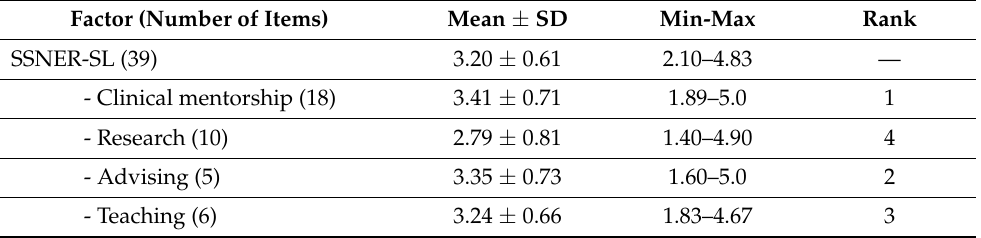
Table 7. Self-efficacy of nursing educators’ roles in Sri Lanka ( n =